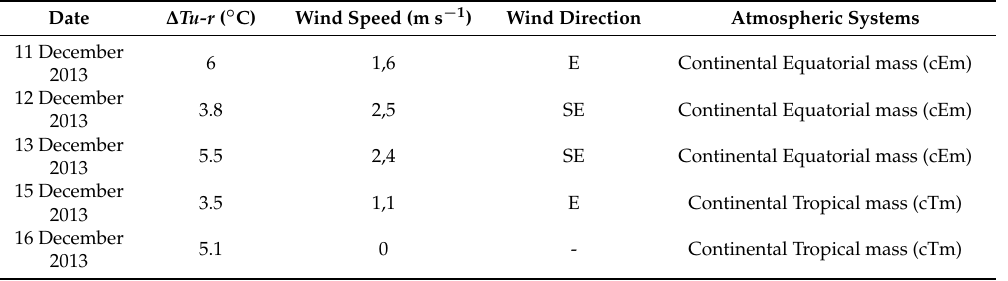
Table 3. Urban heat island magnitude and atmospheric systems during nighttime traverses in Presidente Prudente, December